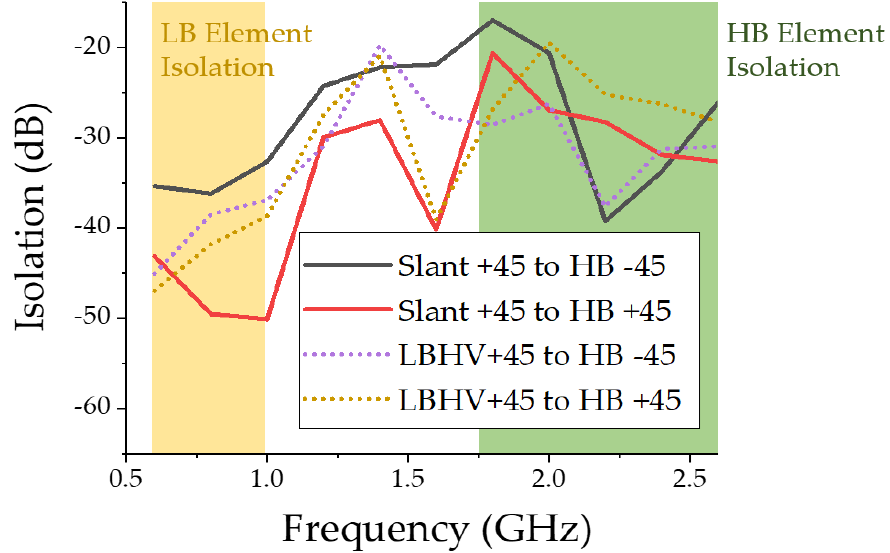
Figure 10. Measured isolation of proposed antenna LBHV with slant.